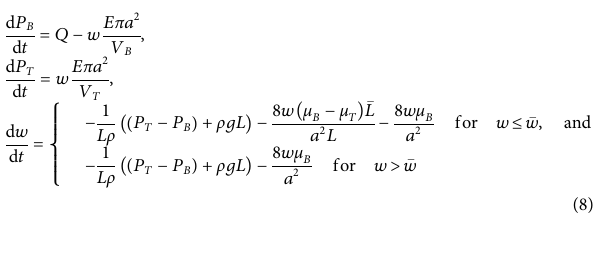
Frontiers in Earth Science |